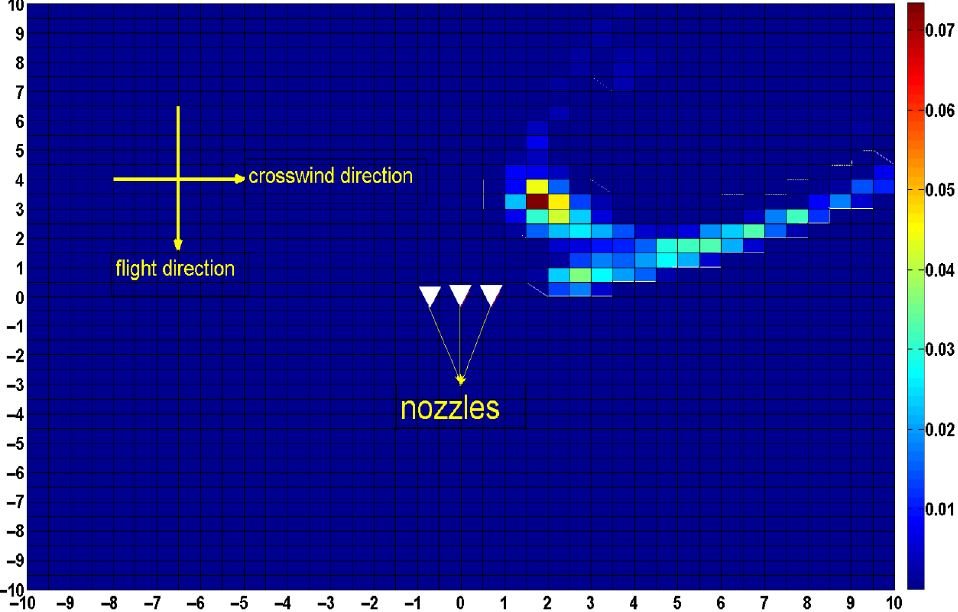
Figure 20. Droplet deposition distribution at a flight height of 3 m, crosswind speed of 2 m/s, and flight speed of 2 m/s,flight direction in the y-axis-negative half-axis direction. Case 3: Flight height of 3 m, the flight speed of 1 m/s, flight direction in the y-axis- negative half-axis direction, crosswind speed of 2 m/s, flight direction in the x-axis-posi- tive half-axis direction, and flight direction clip angle of 45°.